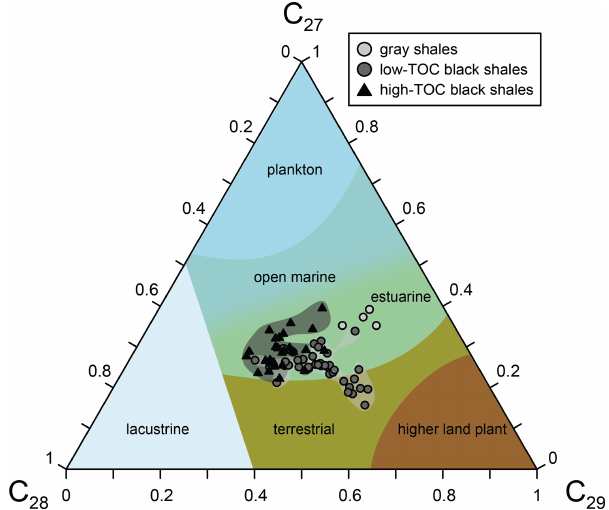
Figure 9. Ternary diagram showing the distribution of regular desmethylsteranes in gray shales, low-TOC black shales ( < 6% TOC), and high-TOC black shales ( > 6% TOC). Organic car- bon source end-members were adapted from Huang and Mein- schein